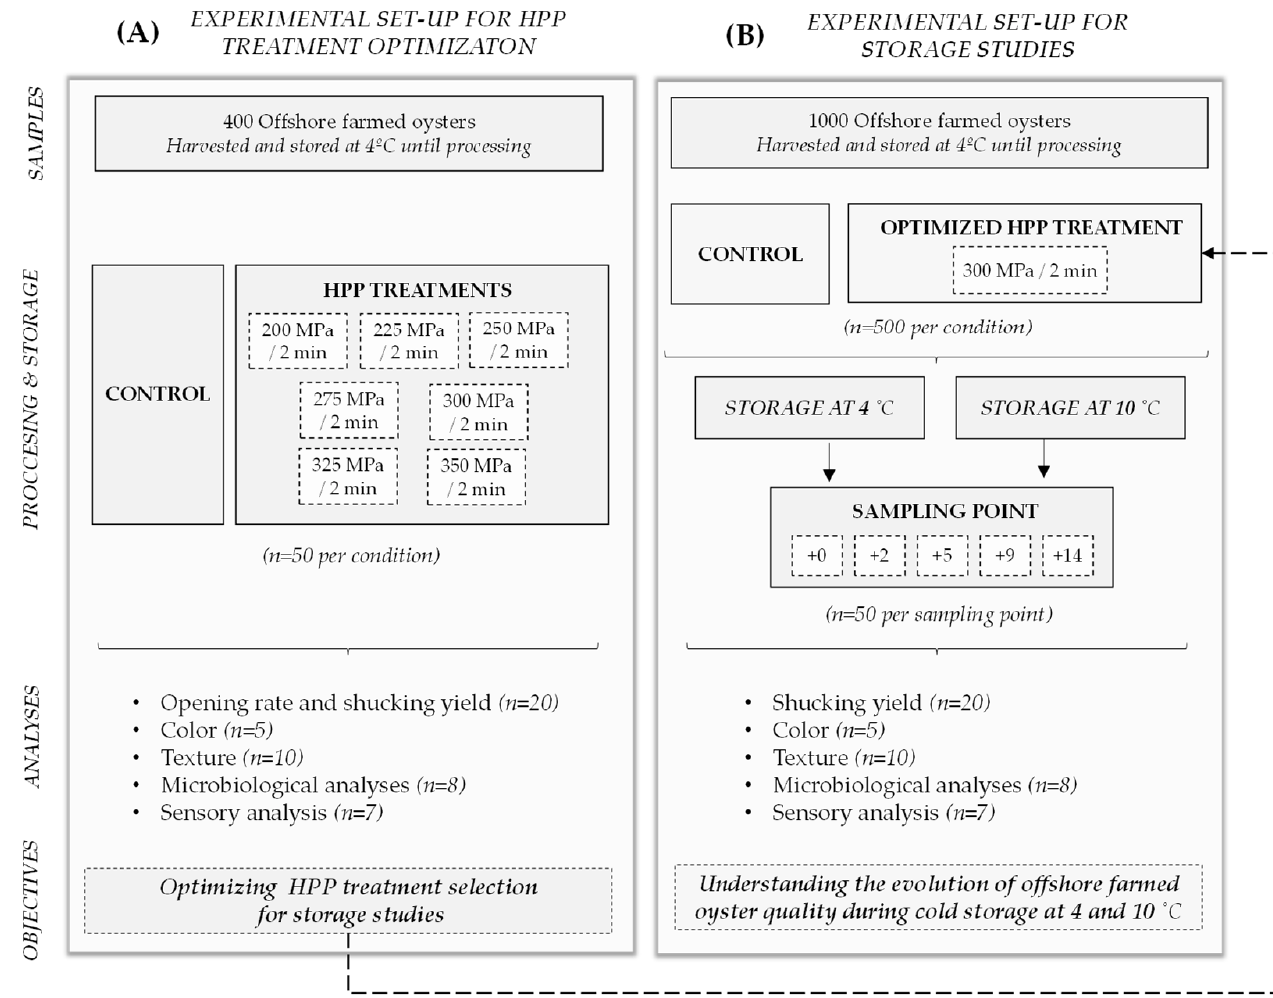
Figure 1. Schematic overview of the experimental program used in this work, for the optimization of the HPP treatment ( A ) and for the storage studies ( B